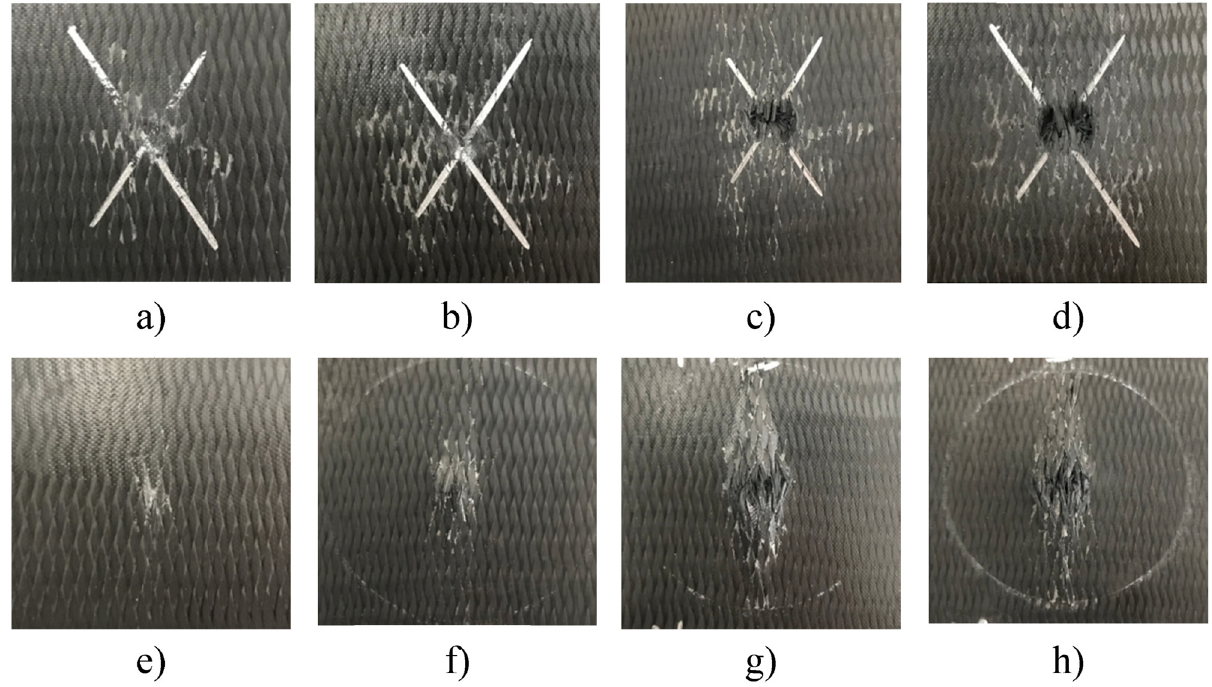
Figure 5: Surface damage of 15° braided angle specimens after impact of spherical punch: ( a ) top surface after 1 impact, ( b ) top surface after 5 impacts, ( c ) top surface after 20 impacts, ( d ) top surface after 28 impacts, ( e ) backside after 1 impact, ( f ) backside after 5 impacts, ( g ) backside after 20 impacts, and ( h ) backside after 28 impacts.